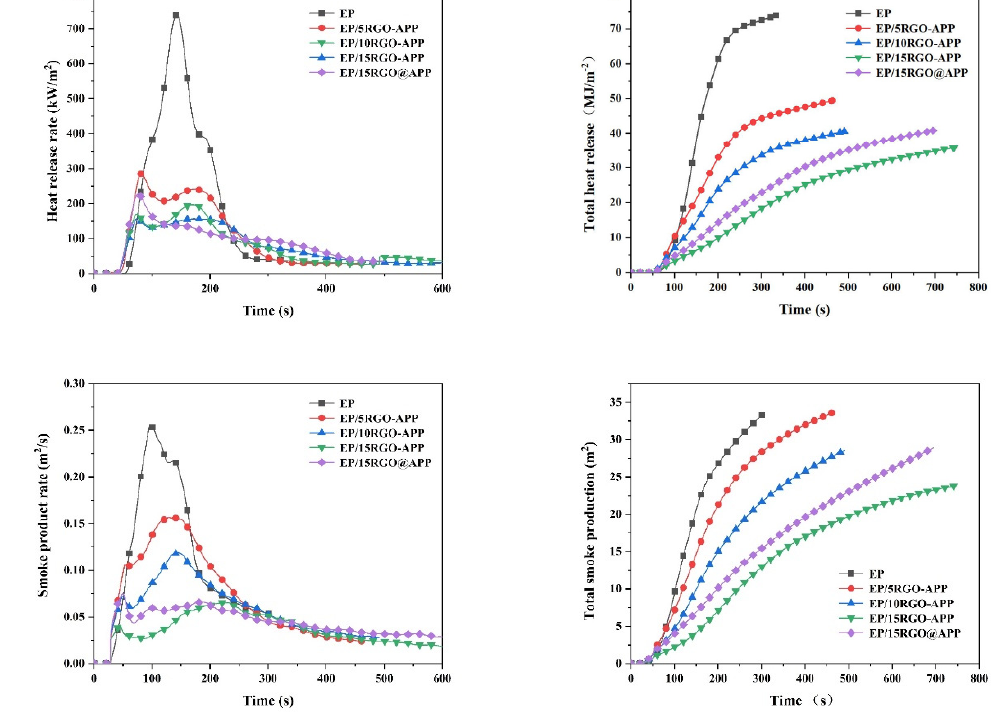
Figure 8. HRR, THR, SPR, and TSP curves of pure EP and flame-retardant EP.